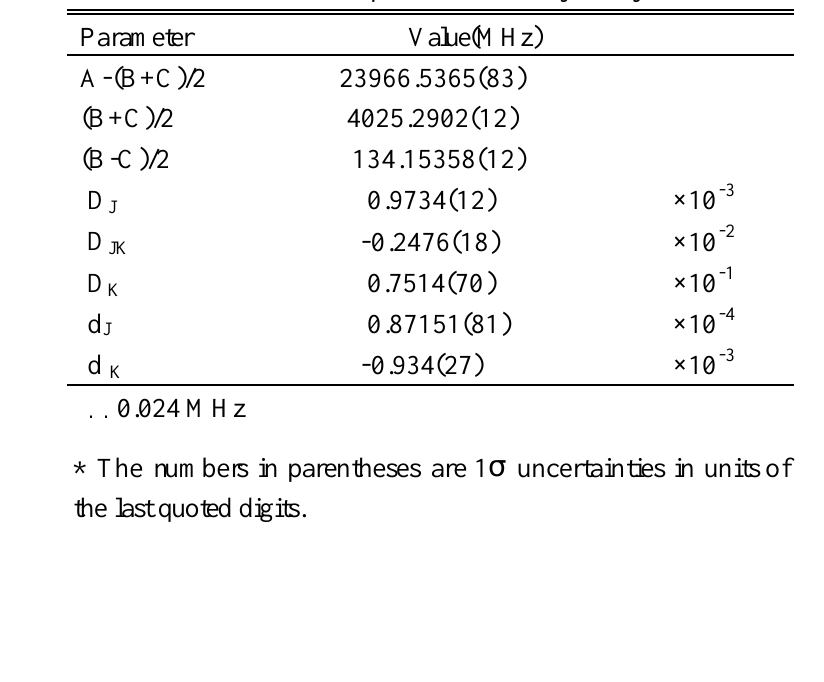
Table 2. Molecular parameters of Ethylmethyl